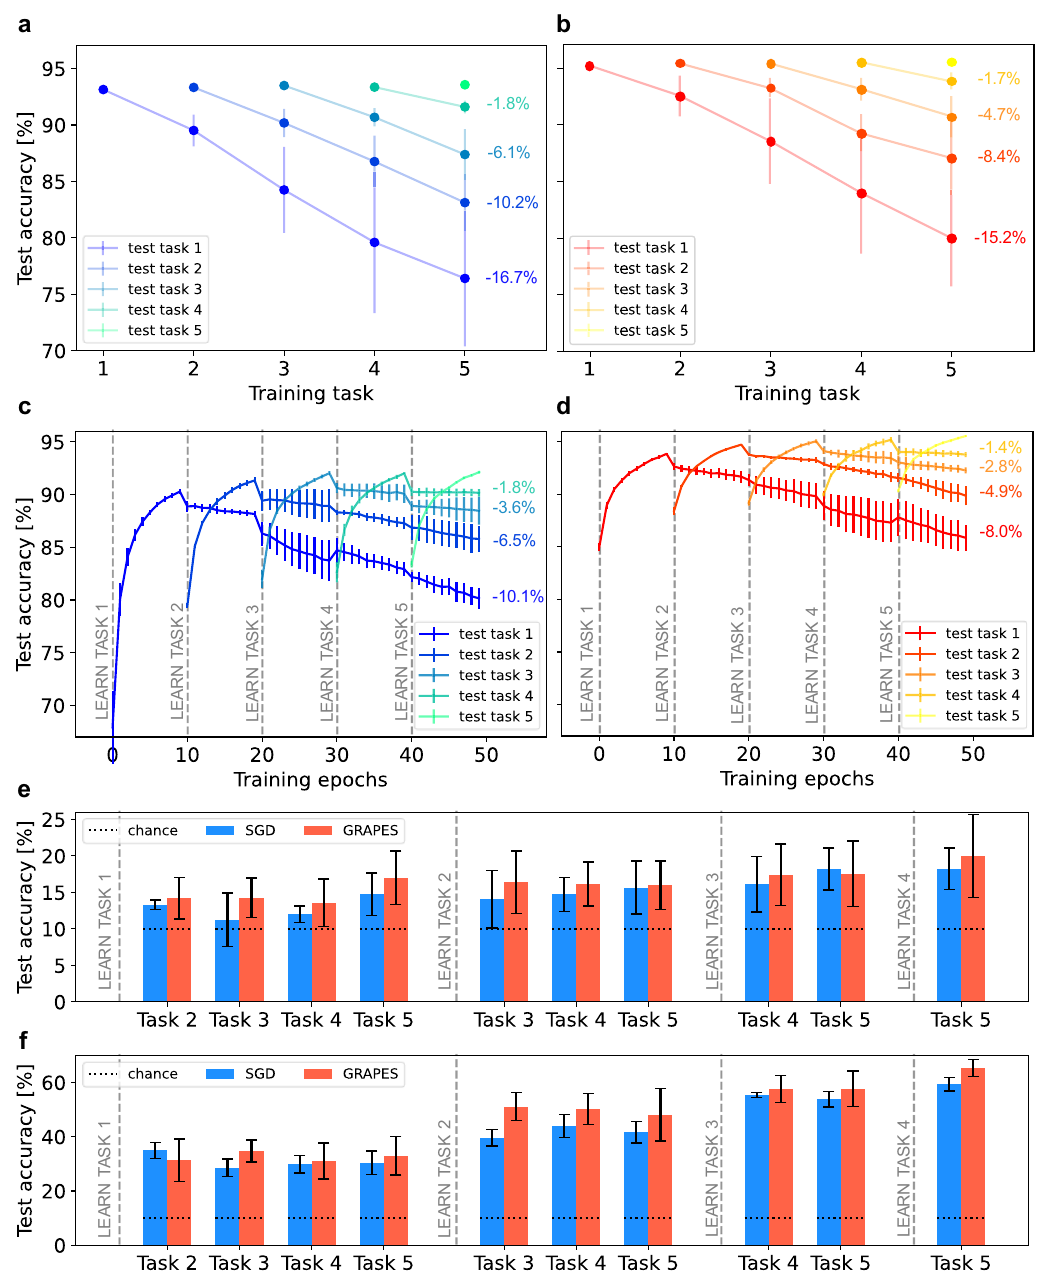
Fig. 6 Mitigation of catastrophic forgetting. Following the protocol in ref. 54 for catastrophic forgetting, we train ReLU networks with SGD with and without GRAPES on a sequence of tasks. Each task is de fi ned by a random pattern of N p pixel permutations, which is applied to all MNIST train and test images. The networks are trained sequentially on each task for N e epochs. At the end of each training epoch, the networks are tested on both the task they are being trained on as well as the tasks they have already learnt (e.g., while learning task 1 they are tested only on task 1, and while learning task 2 they are tested on both task 2 and 1 to observe performance degradation on task 1). Panels a and b show the resulting test curves for 2 × 256 networks trained on the Avalanche benchmark with N p = 28 × 28 permutations (i.e., no overlap between tasks) and N e = 1 epoch per task. For the optimization, we used SGD with momentum with default parameters. The results are mean and standard deviation over ten independent runs. Panels c and d show the resulting test curves for 3 × 256 networks trained with N p = 600 permutations (i.e., small overlap between tasks) and N e = 10 epochs per task. For the optimization, we used SGD without momentum. Panels e and f report the per-task-future-accuracy ( 56 ) on unseen tasks obtained with the same task setup as in ( c ) and ( d ). The tasks are de fi ned by N p = 600 (panel e ) and N p = 300 (panel f ) pixel permutations, respectively. The networks are fi rst trained on each task for N e = 10 epochs and then tested on all the unseen tasks ( e.g. , after learning task 1, the per-task-future-accuracy is reported for unseen tasks 2, 3, 4,